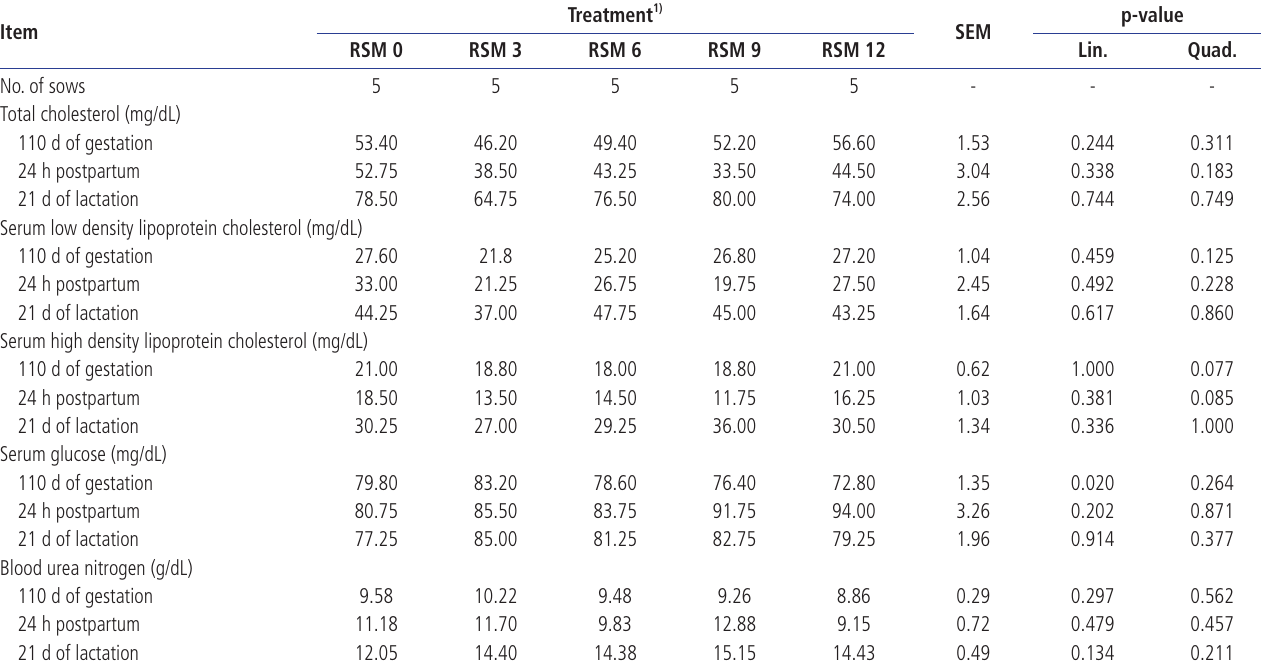
Table 8. Effect of rapeseed meal (RSM) supplementation levels in gestation diets on blood profiles of sows